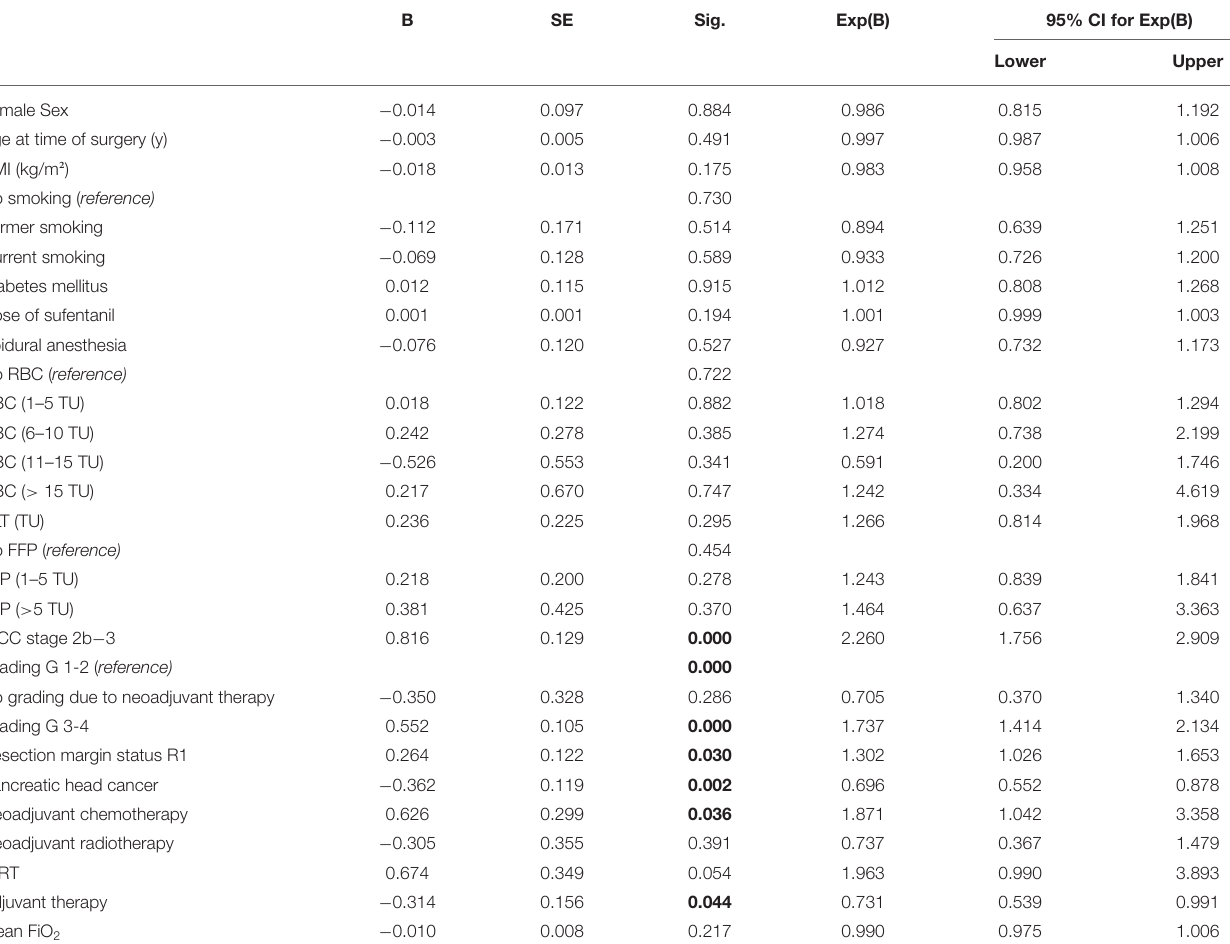
TABLE 3 | Independent effects of FiO 2 on recurrence-free survival in patients with